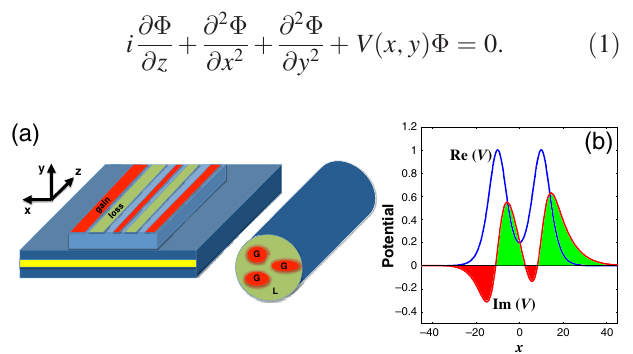
FIG. 1. Schematic depiction of non-normal photonic wave- guide structures in (a) semiconductor slab waveguide and an optical fiber. In both figures, the green and red shaded regions represent the lossy and gainy regions, respectively. The propa- gation distance is denoted by z . (b) Real (blue curve) and imaginary (red curve) part of the non-normal optical potential that we consider in the text, for g ¼ 0 . 5 . The green filled areas denote the lossy parts of the potential, while the red filled areas stand for the gain